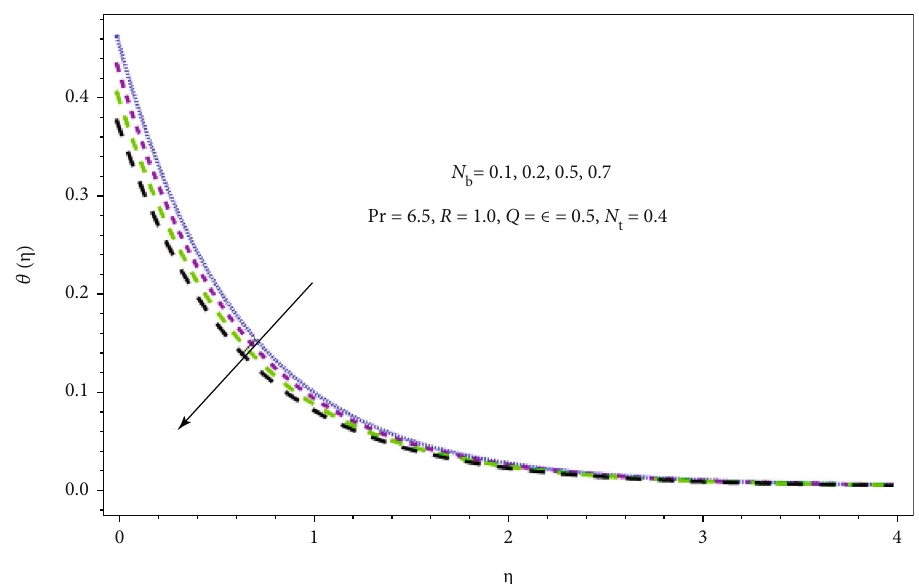
Figure 10: Graphical view of the e ff ect of N